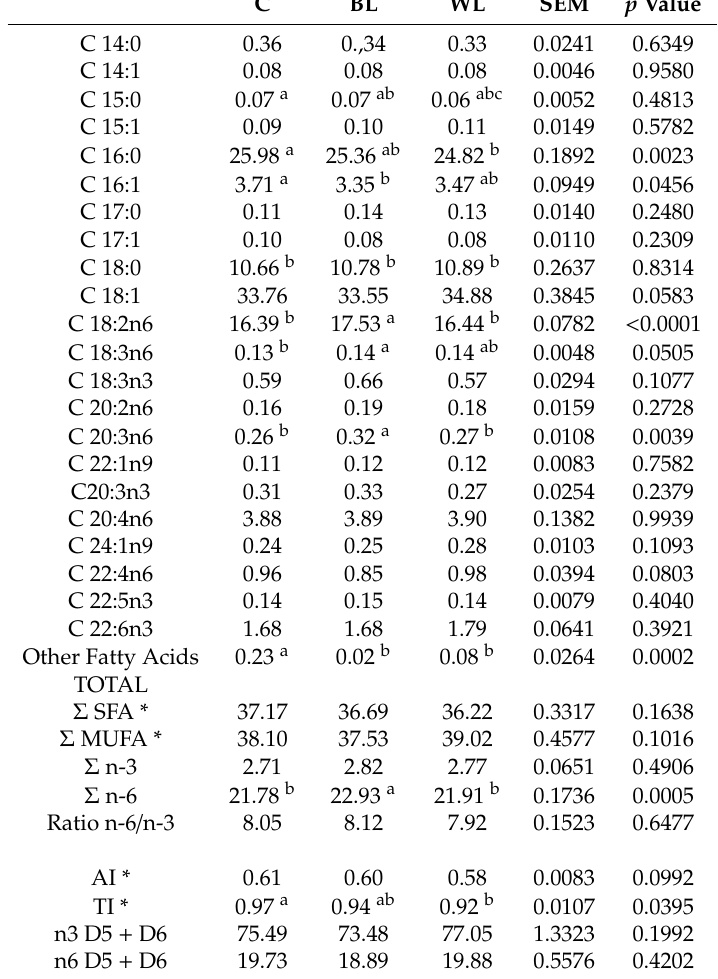
Table 5. The fatty acid composition of egg yolks, collected at the end of the